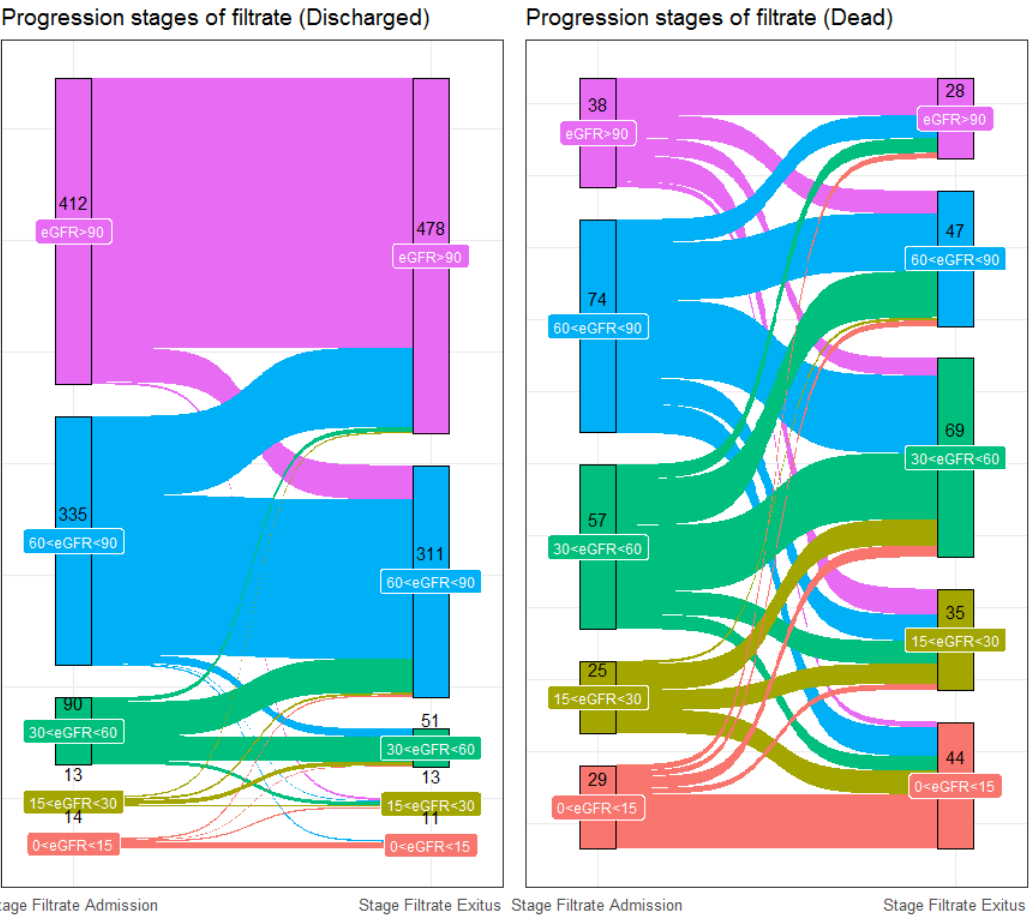
Figure 3. Sankey plot showing the progression of the stages of eGFR .